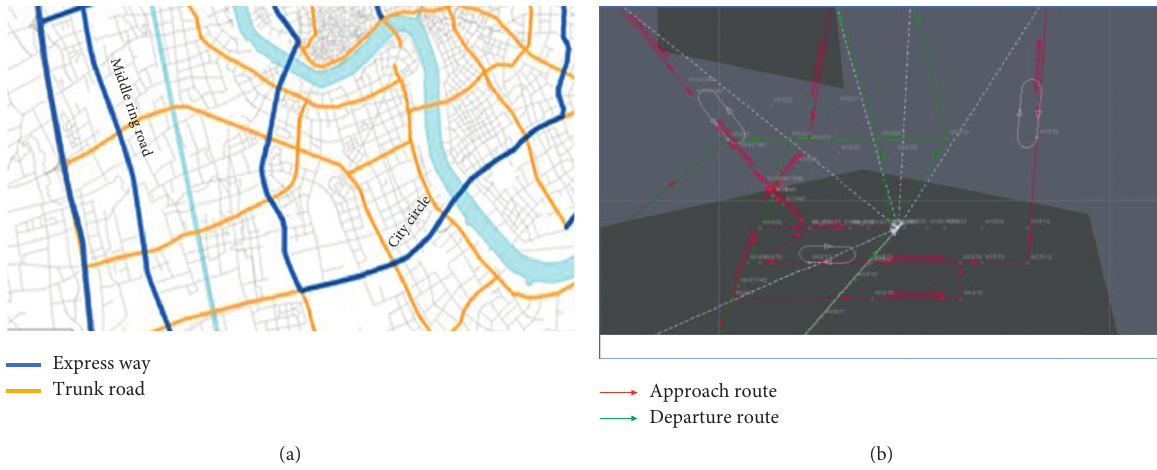
Figure 1: Comparison of urban transportation network and air route network. (a) The urban transportation network. (b) The airport air route